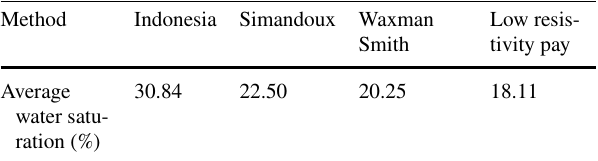
Table 8 Results of different saturation methods